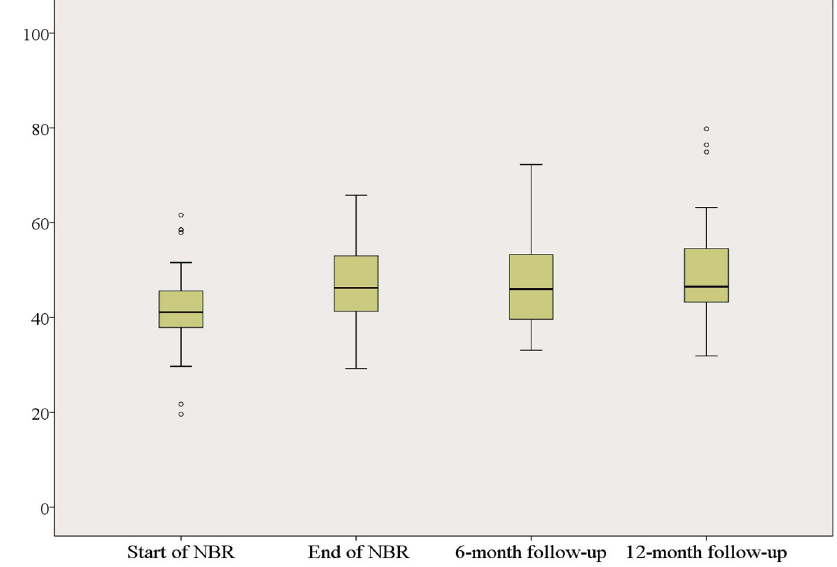
Figure 7. PGWB 8 metric scores at start of NBR, at the end of NBR and at six- and